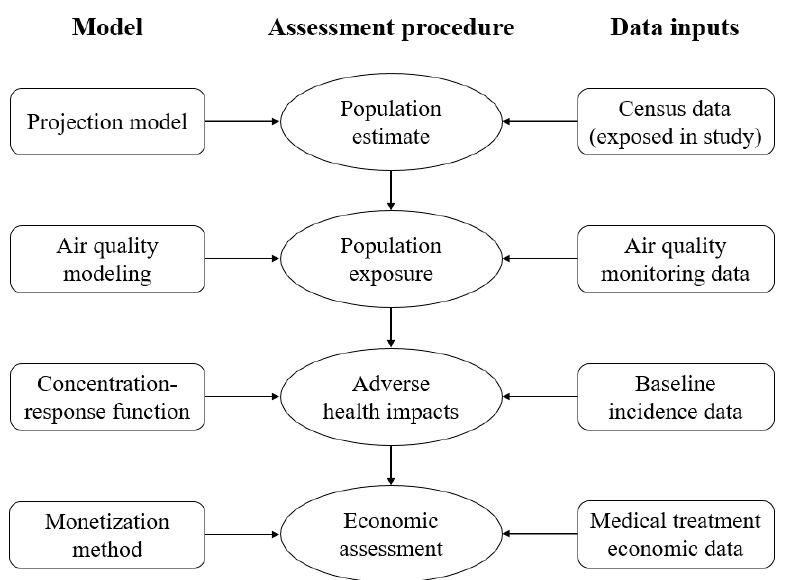
Figure 1. The flow diagram of Air Pollution Health Risk Assessment (AP-HRA) methods, typical models, and data inputs.